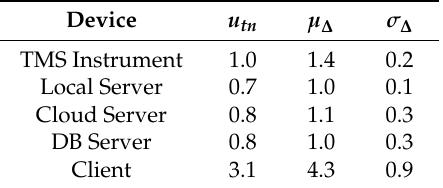
Table 2. Timestamp uncertainty of the devices involved in the experiments